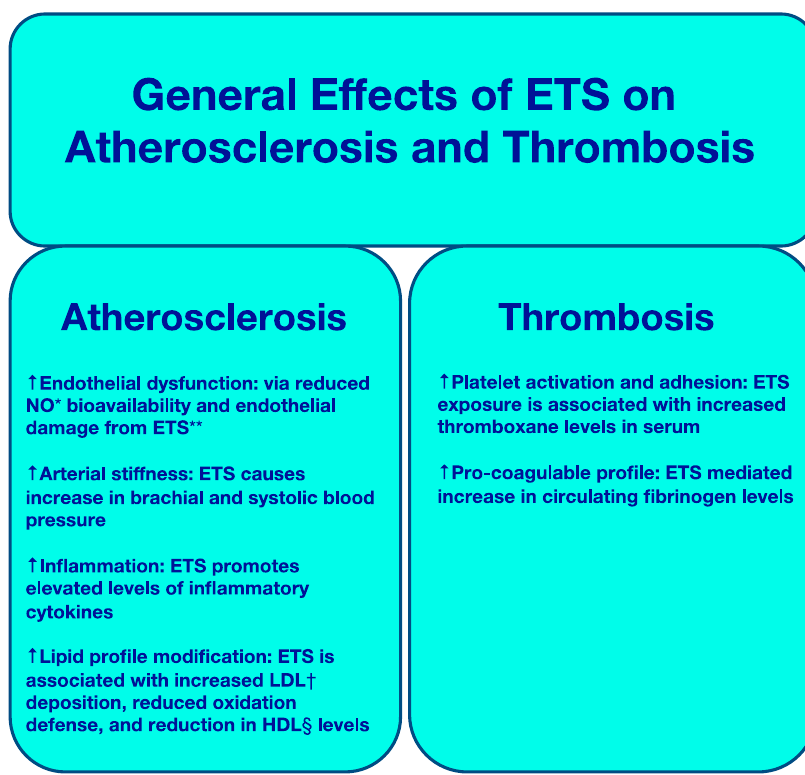
Figure 1. Effects of ETS on Atherosclerosis and Thrombosis.